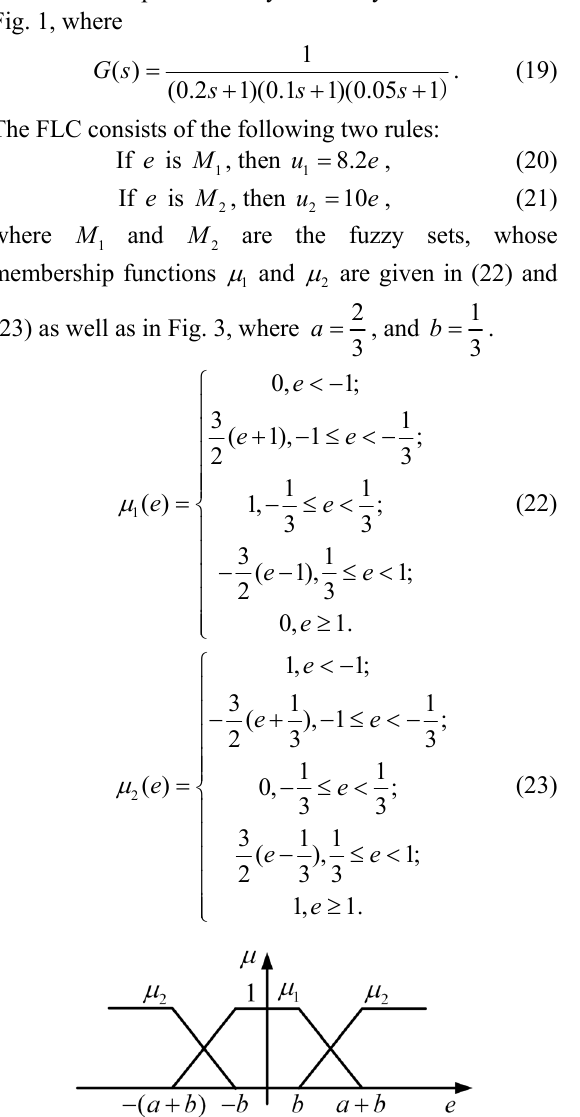
Fig. 3. The membership functions of